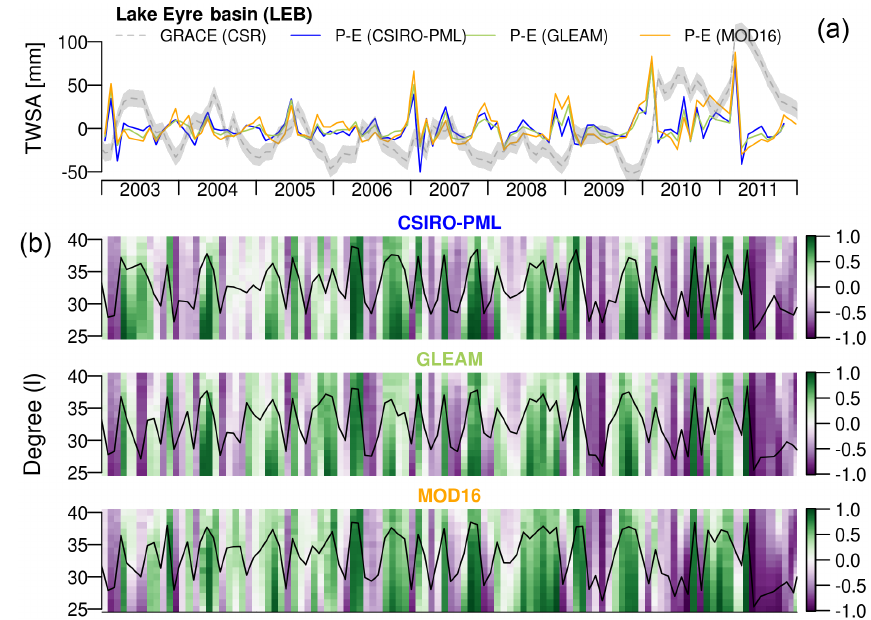
Figure 7. Top: anomalies of the terrestrial water storage (TWSA) observed by GRACE (with 20mm uncertainty bounds) and P − E using three global evaporation products over the Lake Eyre basin. Below: varying degree correlation measure ( r l ) with time and degree (from 25 to 40) using the three global evaporation products. The average r l is shown as a time series (black line). The degree correlation measure can range from − 1 to 1, as shown in the colour scale on the secondary